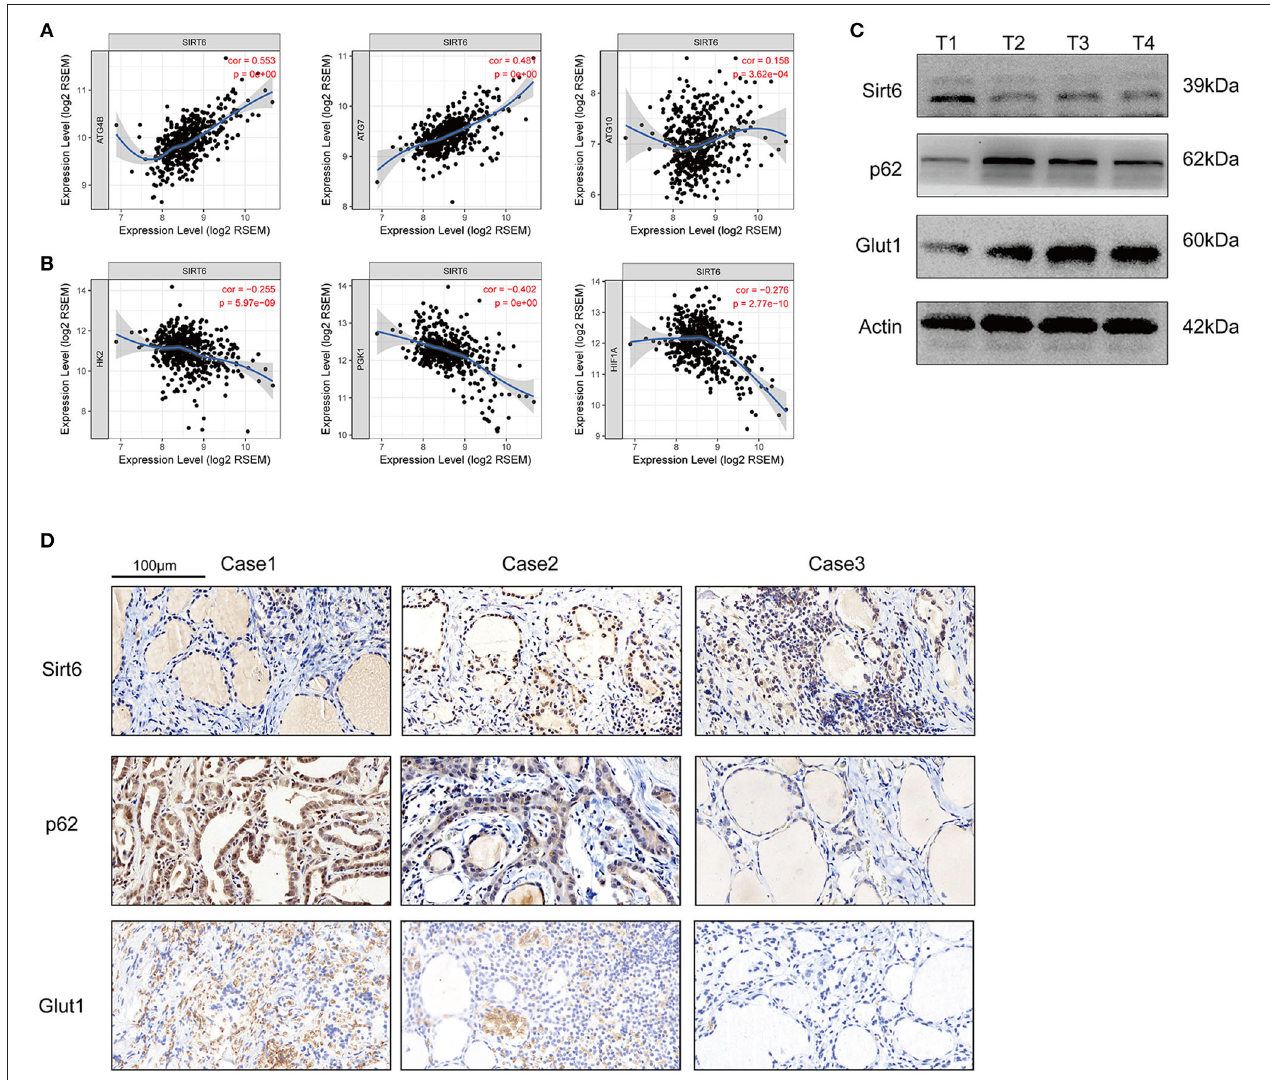
FIGURE 6 | Inspection of the SIRT-autophagy-Warburg effect axis in clinical specimens. (A) Co-expression of SIRT6 and autophagy-associated genes (ATGs) analyzed using TIMER web tools based on TCGA database. (B) Co-expression of SIRT6 and Warburg effect-associated genes analyzed using TIMER web tools based on TCGA database. (C) Western blots showing the levels of the SIRT6, P62, and GLUT1 proteins in PTC specimens. (D) IHC staining showing the expression and location of the SIRT6, P62, and GLUT1 proteins in PTC